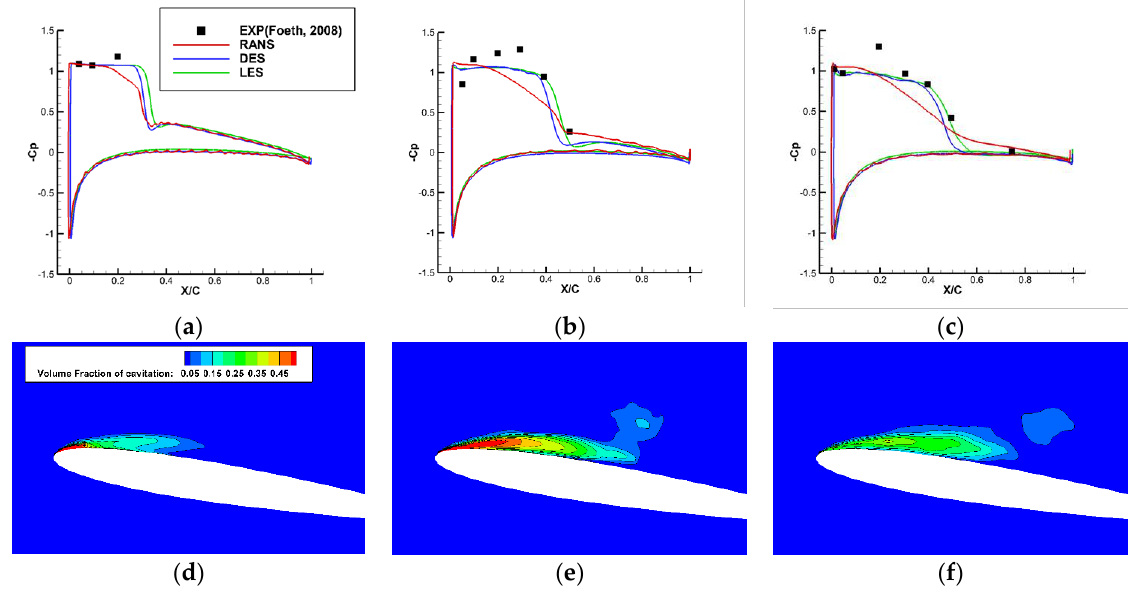
Figure 6. Mean Cp curve of cavitating flow at y/S = 0.3 ( a ), 0.4 ( b ), and 0.5 ( c ) according to turbulence models and mean volume of fraction (VOF) at y/S = 0.5 using RANS ( d ), DES ( e ), and LES ( f ).